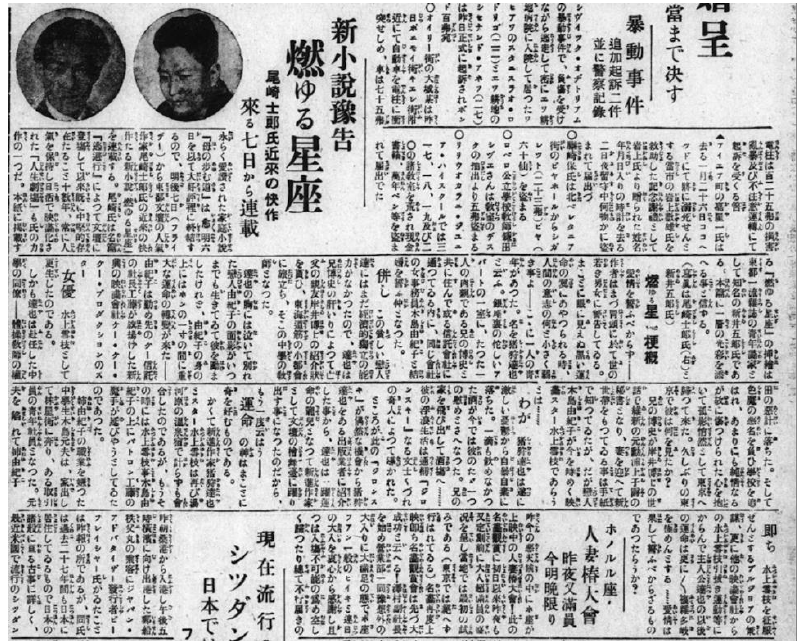
Figure 4. Preview of Constellations Ablaze . Hawai hōchi 5 May 1937. Image courtesy of the Hoji Shinbun Digital Collection.